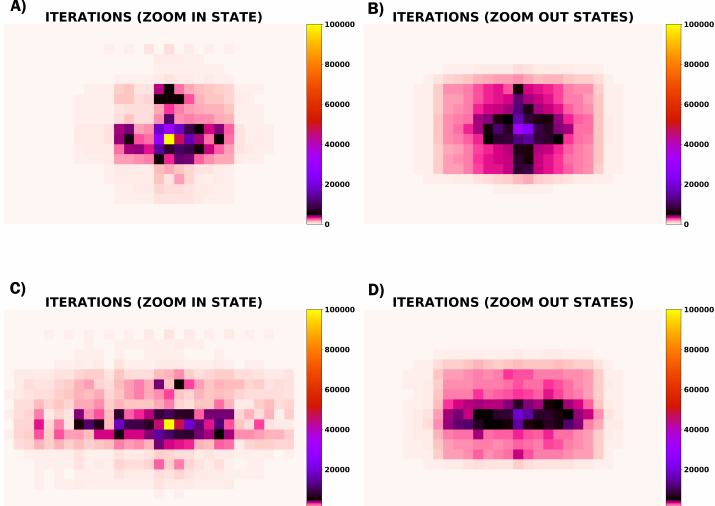
Figure 9. Q-Values of greedy actions for each state in the two possible Zoom configurations after 100,000 training epochs. ( A ) (ZI) and ( B ) (ZO) images corresponds to Agent 8 (Reward Shaping I) and ( C ) (ZI) and ( D ) (ZO) images are for Agent 8 (Reward Shaping II).